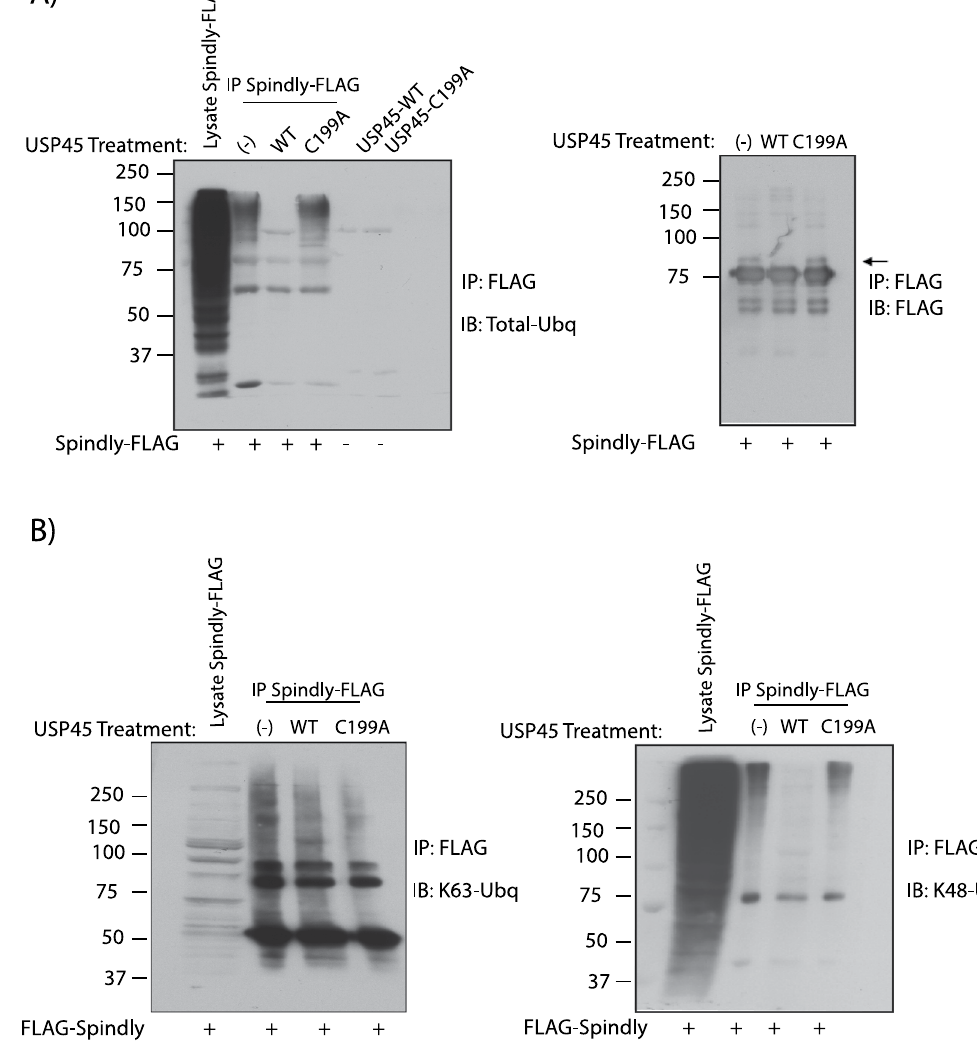
Figure 3. K48 ubiquitin chains that are cleaved by USP45 are part of the Spindly complex. ( A ) U2OS cells were transiently transfected with a construct encoding FLAG-Spindly. Thirty-six hours post-transfection cells were lysed and immunoprecipitation against anti-FLAG performed. The precipitates were treated in the absence or presence of 0.1 μ g of recombinant USP45 wild-type (WT) or catalytic inactive USP45 (C199A). Analysis was performed by immunoblotting for total ubiquitin (Total-Ubq FK2) (left-hand side) and immunoprecipitation was confirmed by immunoblot with anti-FLAG antibody (right-hand side). ( B ) Similar experiment as in A, developed with K63 ubiquitin specific chain (left panel) and K48 ubiquitin specific chain antibody (right panel). ( A , B ) All experiments were performed at least three times and a representative example is